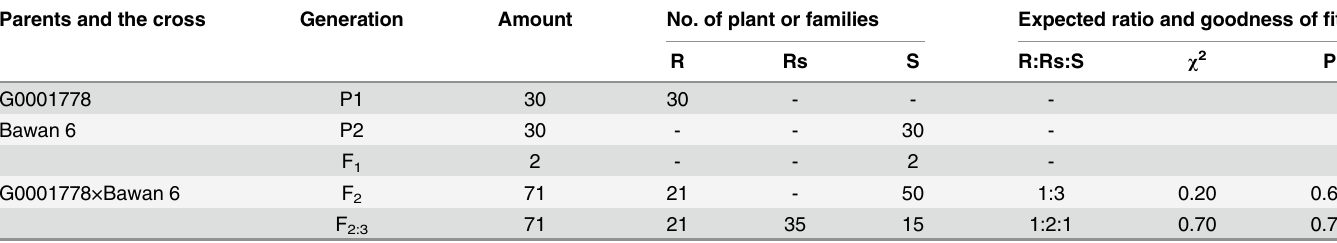
Table 3. Genetic analysis of pea landrace G0001778 carrying the er1 -6 allele for powdery mildew resistance ( E . pisi ). Parents and the